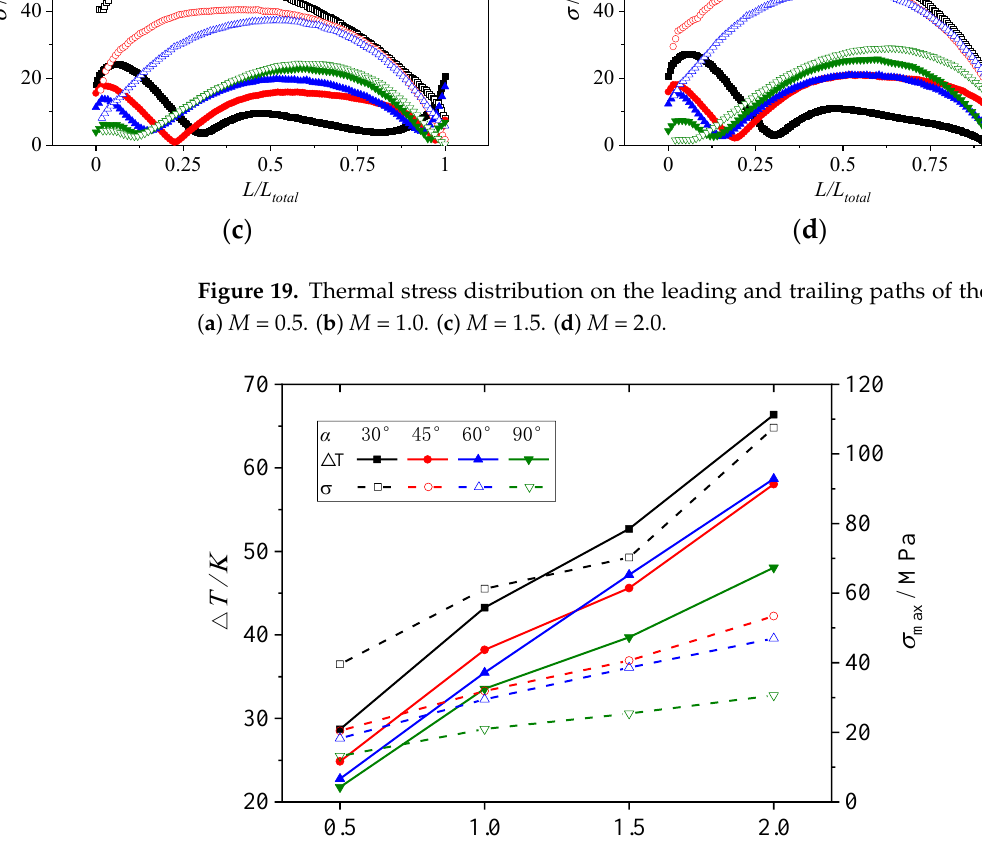
Figure 20. Temperature differences and the maximum stress values of the research film hole under